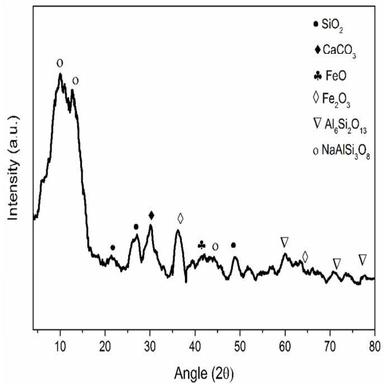
X-Ray Diffraction of Coal bottom ash